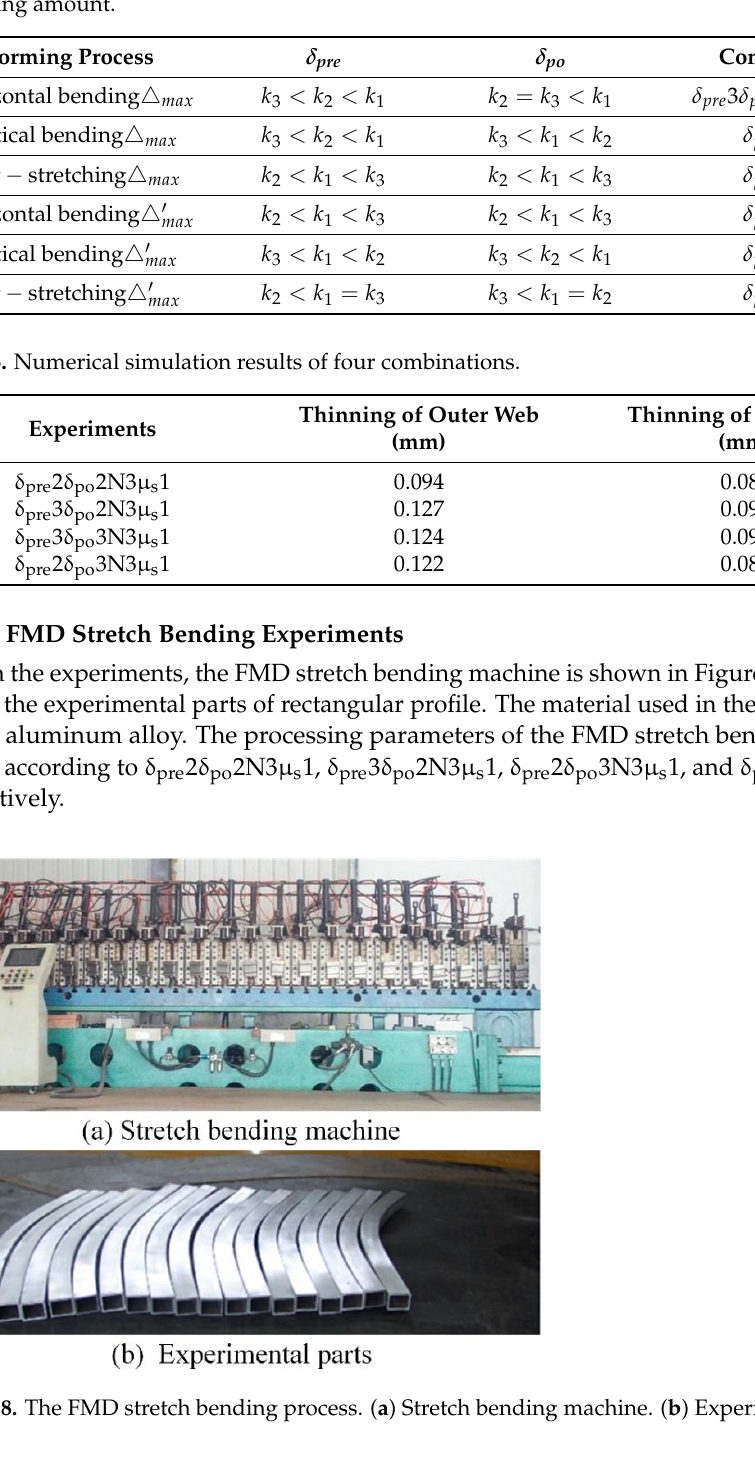
Table 5. Optimal combination design of process parameters of pre-stretching amount and post- stretching amount.